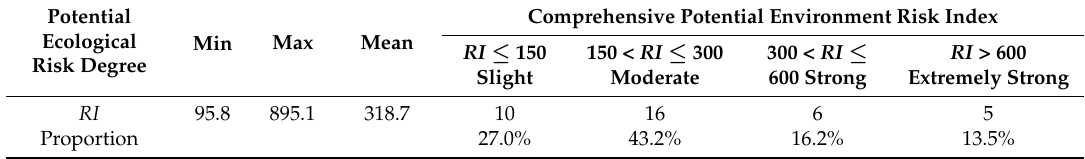
Table 8. RI classification of P. notoginseng cultivation